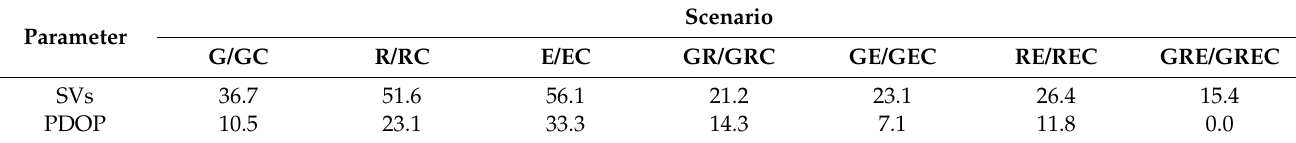
Table 6. Number of SVs and PDOP percentage improvement rates